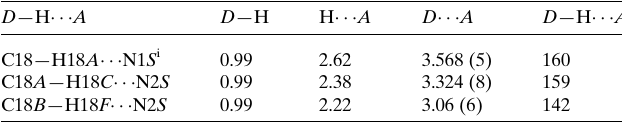
Table 1 Hydrogen-bond geometry (A˚ , (cid:4) ).